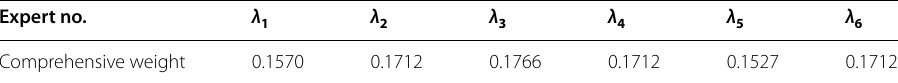
Table 3 Expert weight Expert no. Comprehensive weight